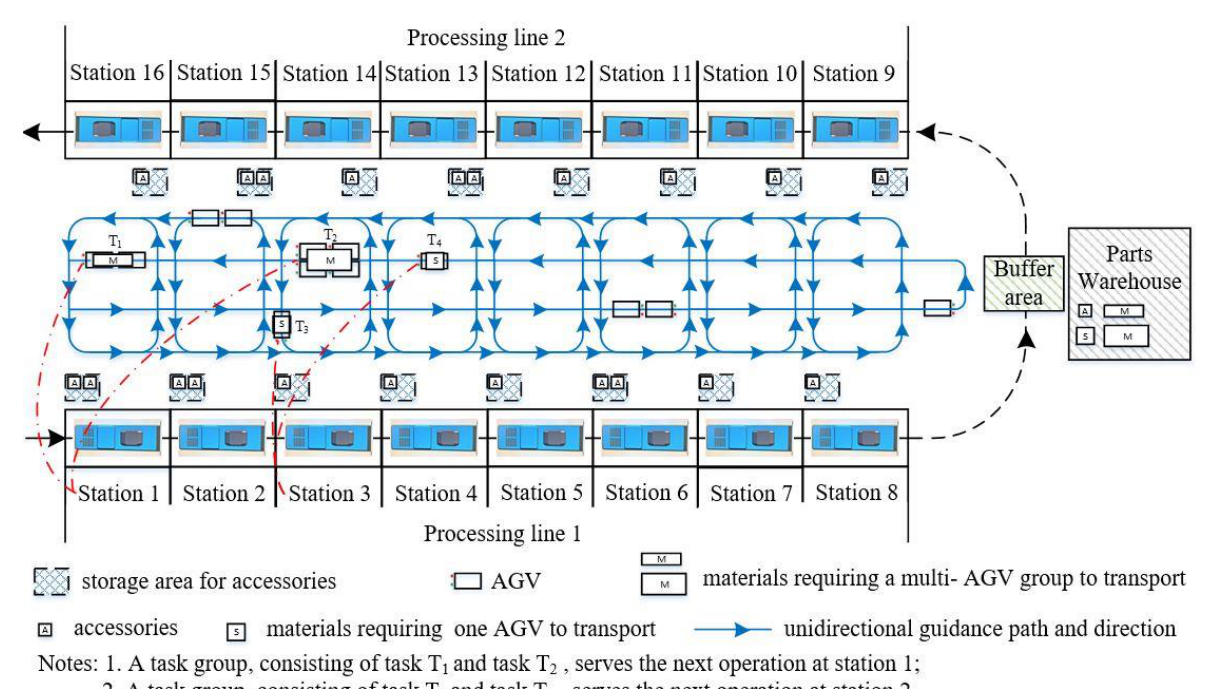
Figure 1. Schematic layout of a bus chassis assembly line with an AGV system.